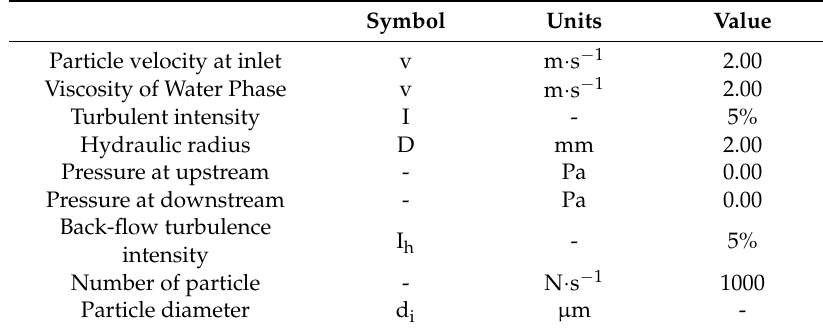
Table 3. Boundary